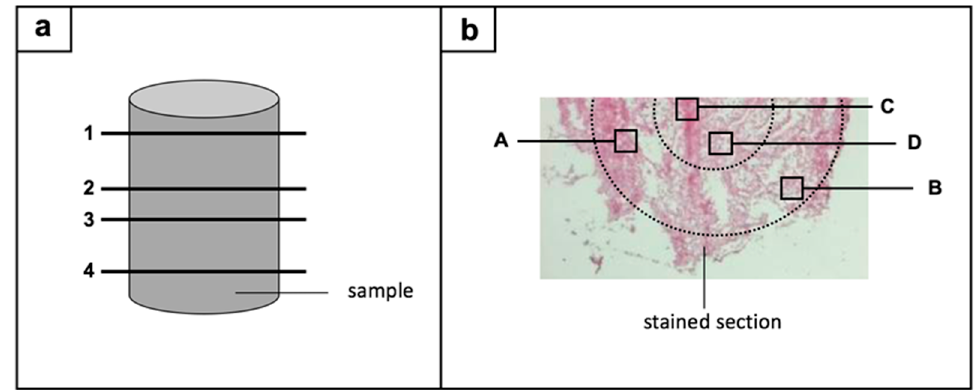
Figure 1. Regions-of-interest are illustrated in a two-way-process: ( a ) four sections (1–4) were chosen from each sample: one from the upper area, two from the middle, and one section from the lower area; ( b ) next, four regions per section were histologically evaluated: two edge regions (A,B) and two central regions (C,D).